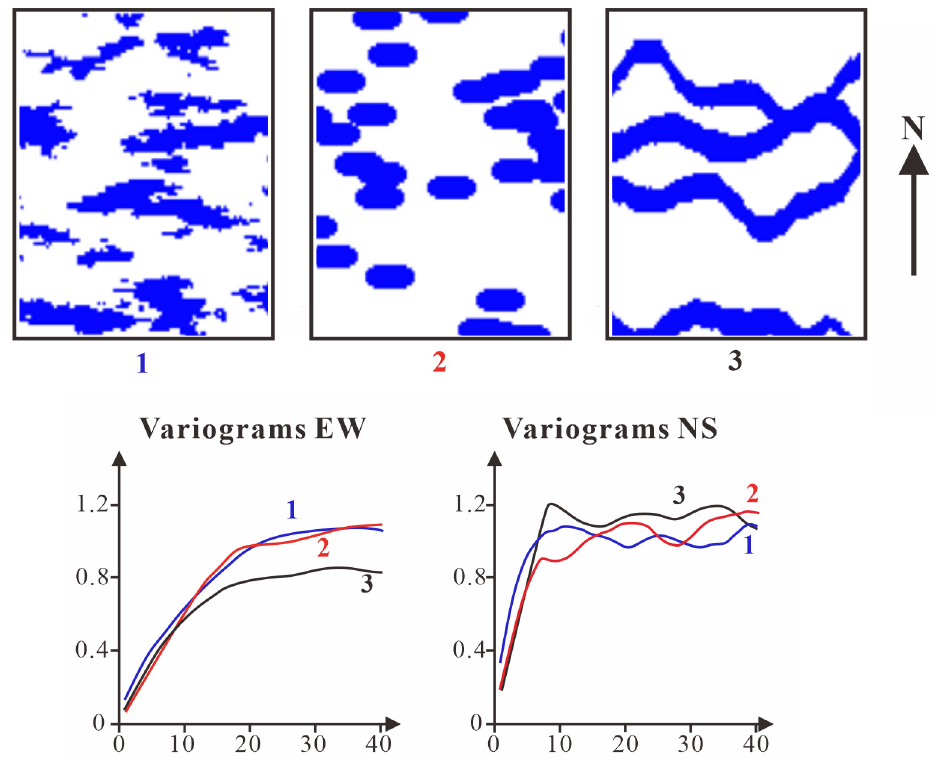
Figure 4. The variation function cannot fully reflect the spatial structure (edited from [73]): the variation functions in East–West and North–South directions under three different models